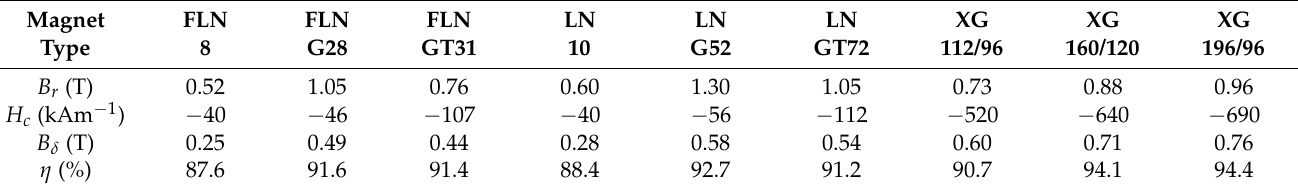
Table 1. Characteristics of the AFRC unit using different types of permanent magnets.